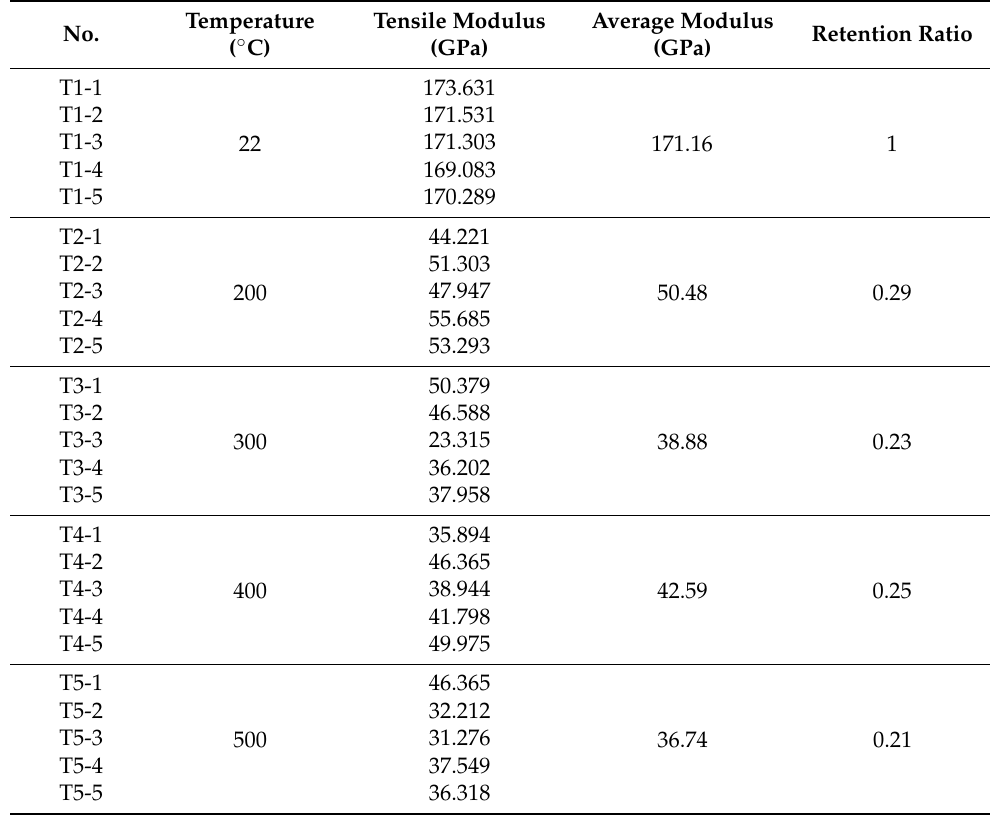
Table 4. Test results of the tensile elastic modulus of unidirectional CFRP plate